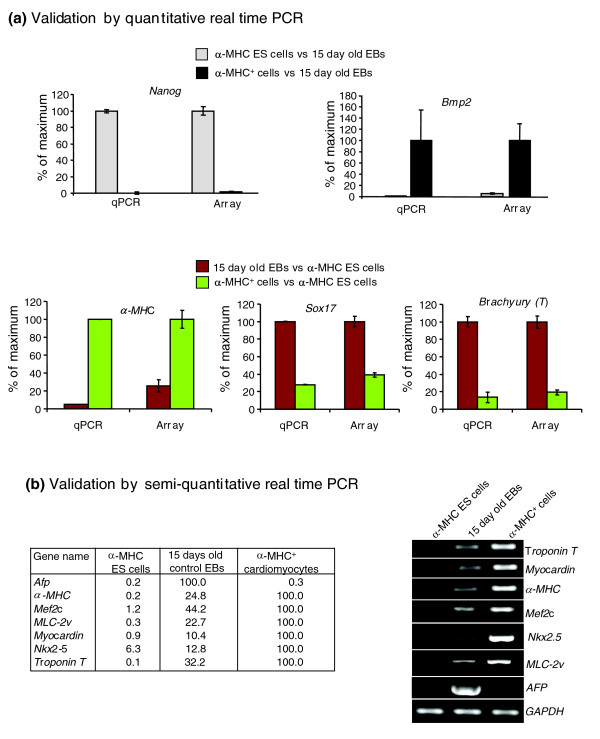
Validation of Affymetrix data by quantitative real-time PCR and semi-quantitative PCR analyses. (a) Validation of Affymetrix data by quantitative real-time polymerase chain reaction (PCR) analyses. The fold change was calculated by using the following formula: fold-change = 2−(ΔCtgene1−ΔCtgene2)
MathType@MTEF@5@5@+=feaafiart1ev1aaatCvAUfeBSjuyZL2yd9gzLbvyNv2Caerbhv2BYDwAHbqedmvETj2BSbqee0evGueE0jxyaibaiKI8=vI8tuQ8FMI8Gi=hEeeu0xXdbba9frFj0=OqFfea0dXdd9vqai=hGuQ8kuc9pgc9s8qqaq=dirpe0xb9q8qiLsFr0=vr0=vr0dc8meaabaqaciGacaGaaeqabaqadeqadaaakeaacaaIYaWaaWbaaSqabeaacqGHsislcaGGOaGaeuiLdqKaae4qamaaBaaameaacaqG0baabeaaliaabEgacaqGLbGaaeOBaiaabwgacaaIXaGaeyOeI0IaeuiLdqKaae4qamaaBaaameaacaqG0baabeaaliaabEgacaqGLbGaaeOBaiaabwgacaaIYaGaaiykaaaaaaa@46CC@. ΔCt of the gene in the sample in which it is expressed lowest is taken as ΔCt gene2 to calculate the fold change using the above formula. The resulting fold change is expressed as percentage of the maximum fold change (= 100%) for that particular gene in every assay. Values are expressed as mean ± standard deviation (n = 3; technical replicates). (b) Additional validation of Affymetrix data by semi-quantitative reverse transcription (RT)-PCR analyses. Randomly chosen candidate genes to validate Affymetrix data by semi-quantitiative RT-PCR analyses and their relative expression values expressed as percentage of maximum expression for every gene, as obtained from Affymetrix profiling, are given in the table.